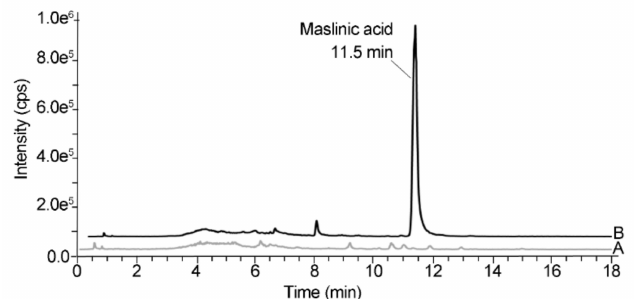
Figure 6. Representative liquid chromatography-mass spectrometry (LC-MS) chromatograms obtained in single ion monitoring (SIM) acquisition mode at m / z 471.3 of the colon content of (A) a rat from the DMH+/MA − group and (B) an animal from the DMH+/MA 10 mg/kg group. The colon content of the rats in the DMH+/MA − group did not show any maslinic acid, whereas free from other interfering peaks, thus indicating the selectivity of the analytical method.